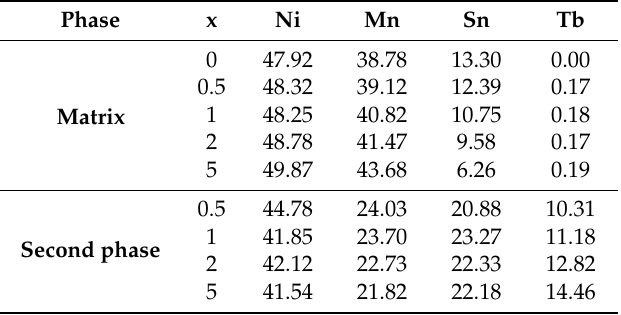
Table 1. The EDS results of Ni 48 Mn 39 Sn 13 − x Tb x (at.%).